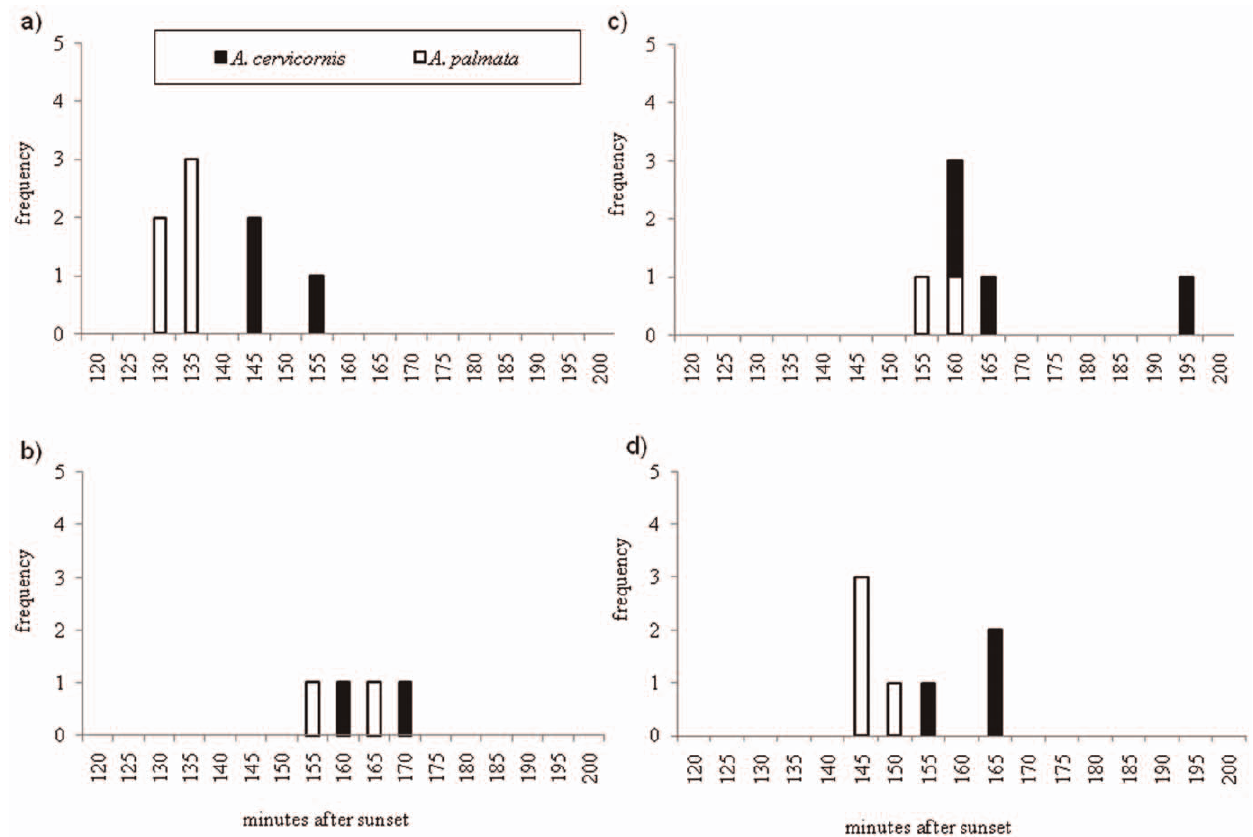
Figure 2. Observations of A.cervicornis and A.palmata spawning on the same night. We observed four separate spawning events where the parental species spawned on the same evening at: a) Florida Keys 2005, b) Belize 2005, c) Belize 2008, and d) Belize 2009.